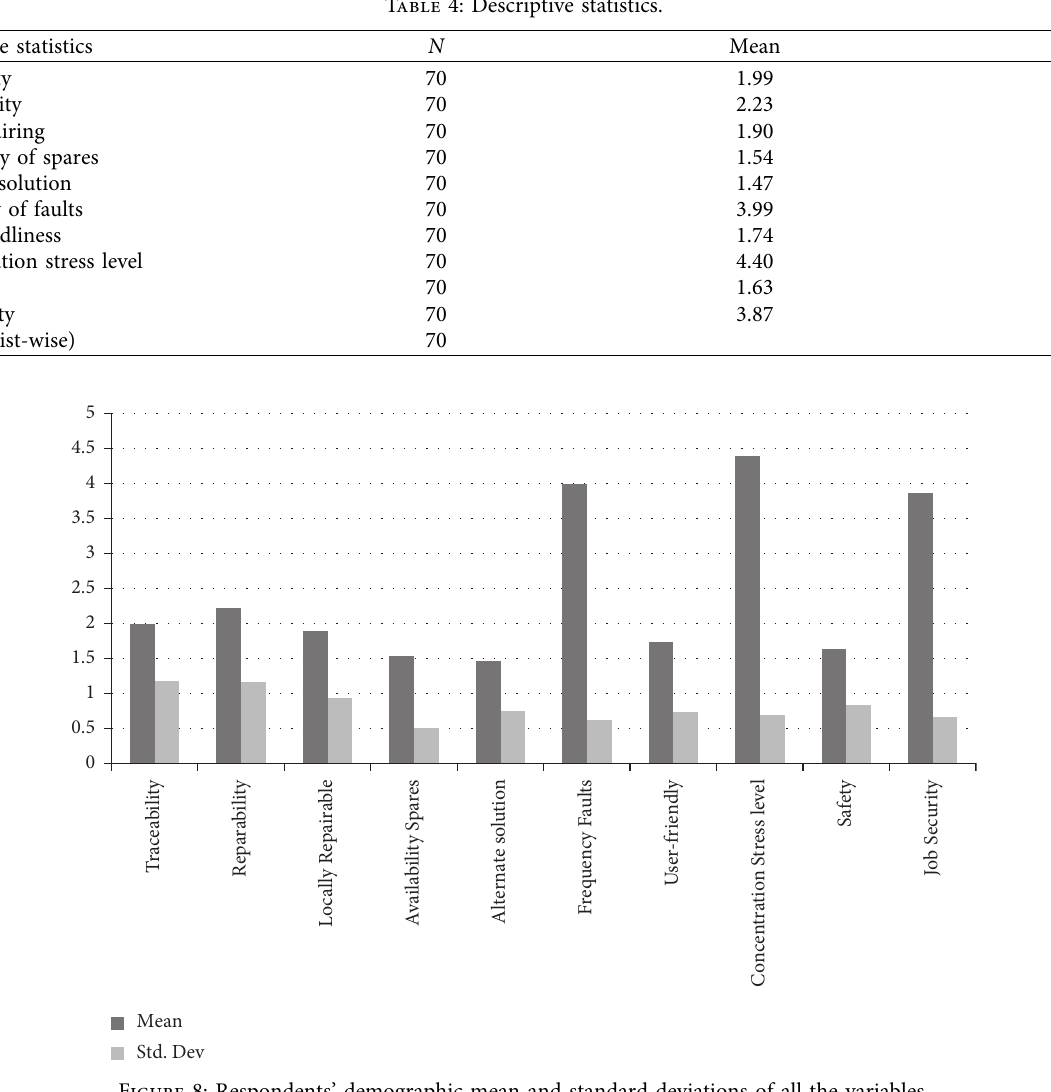
Figure 8: Respondents’ demographic mean and standard deviations of all the variables.